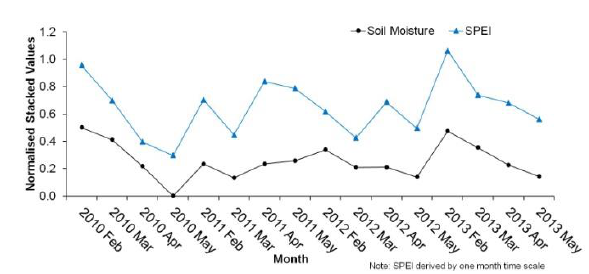
Figure 10. Monthly temporal variation of soil moisture against SPEI during Summer.